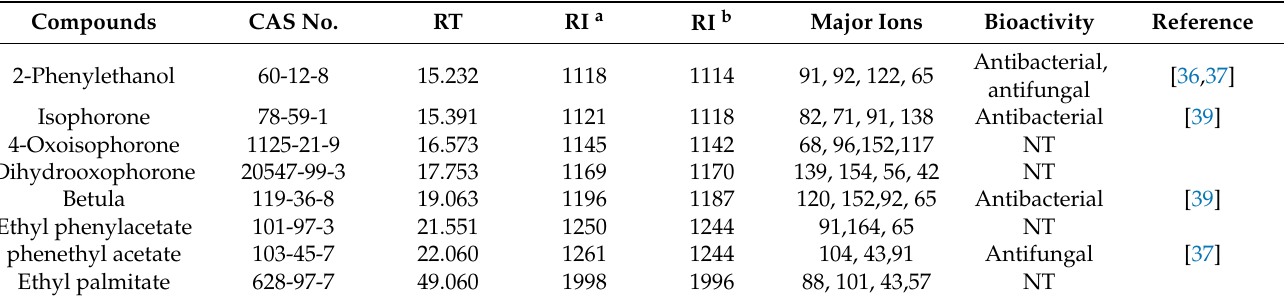
Table 3. Potential markers in ACC identified by GC − MS.